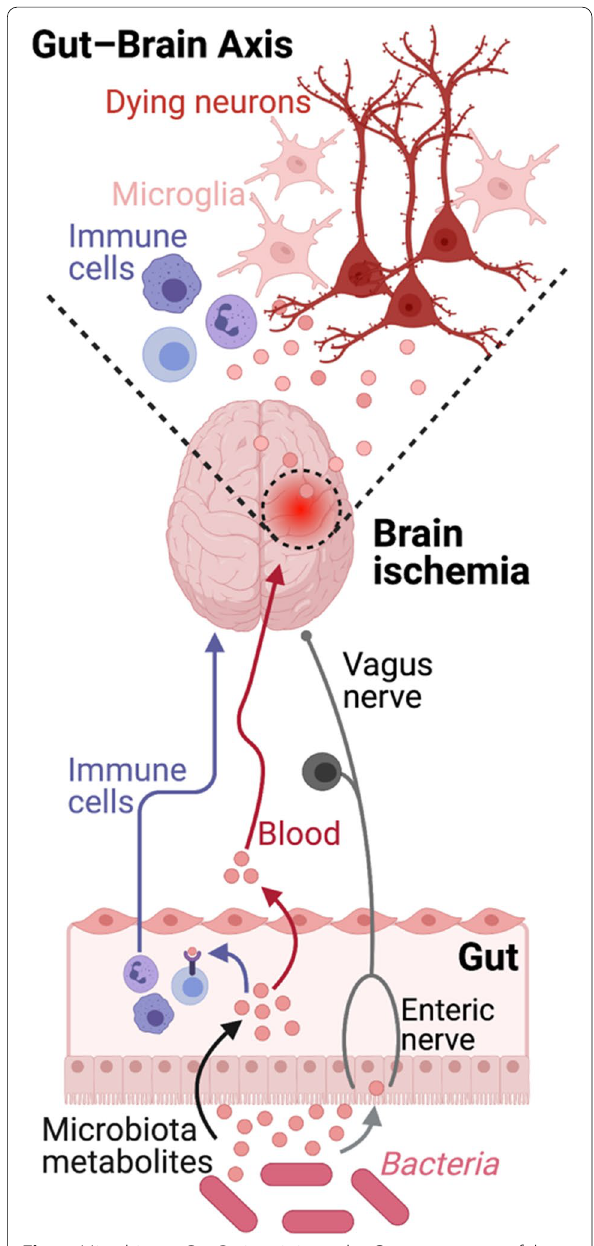
Fig. 1 Microbiome-Gut-Brain axis in stroke. Current concept of the main pathways along the bidirectional gut-brain interaction. Here depicted are the 3 main pathways of brain to gut communication: (1) immune cells via the blood circulation, (2) vagus nerve axis and (3) systemically circulating bacterial metabolites released by